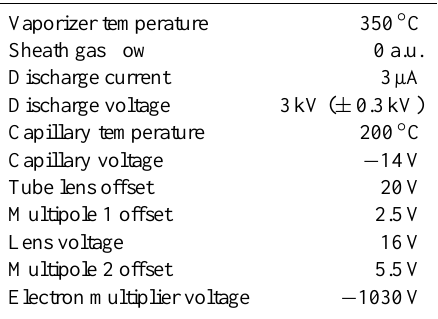
Table 1. Instrument settings of atmospheric pressure chemical ion- ization mass spectrometer